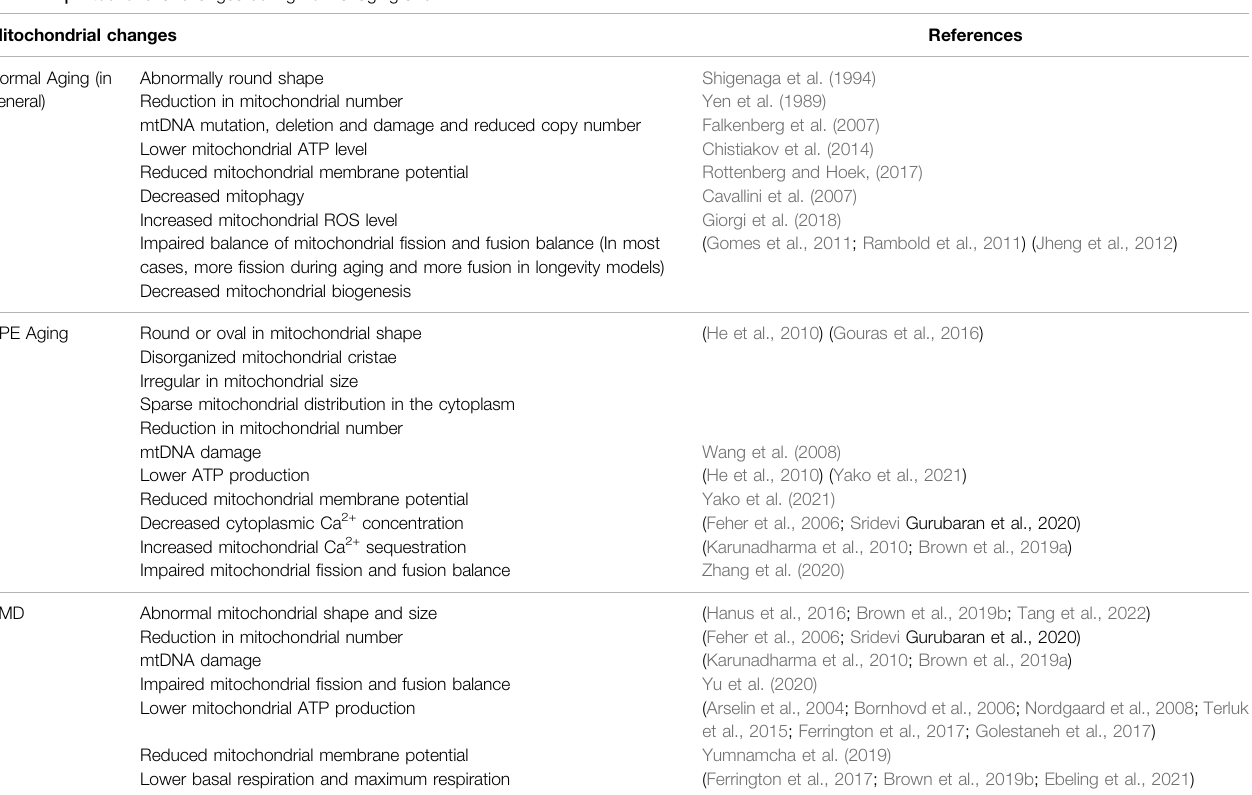
TABLE 2 | Mitochondrial changes during normal aging and